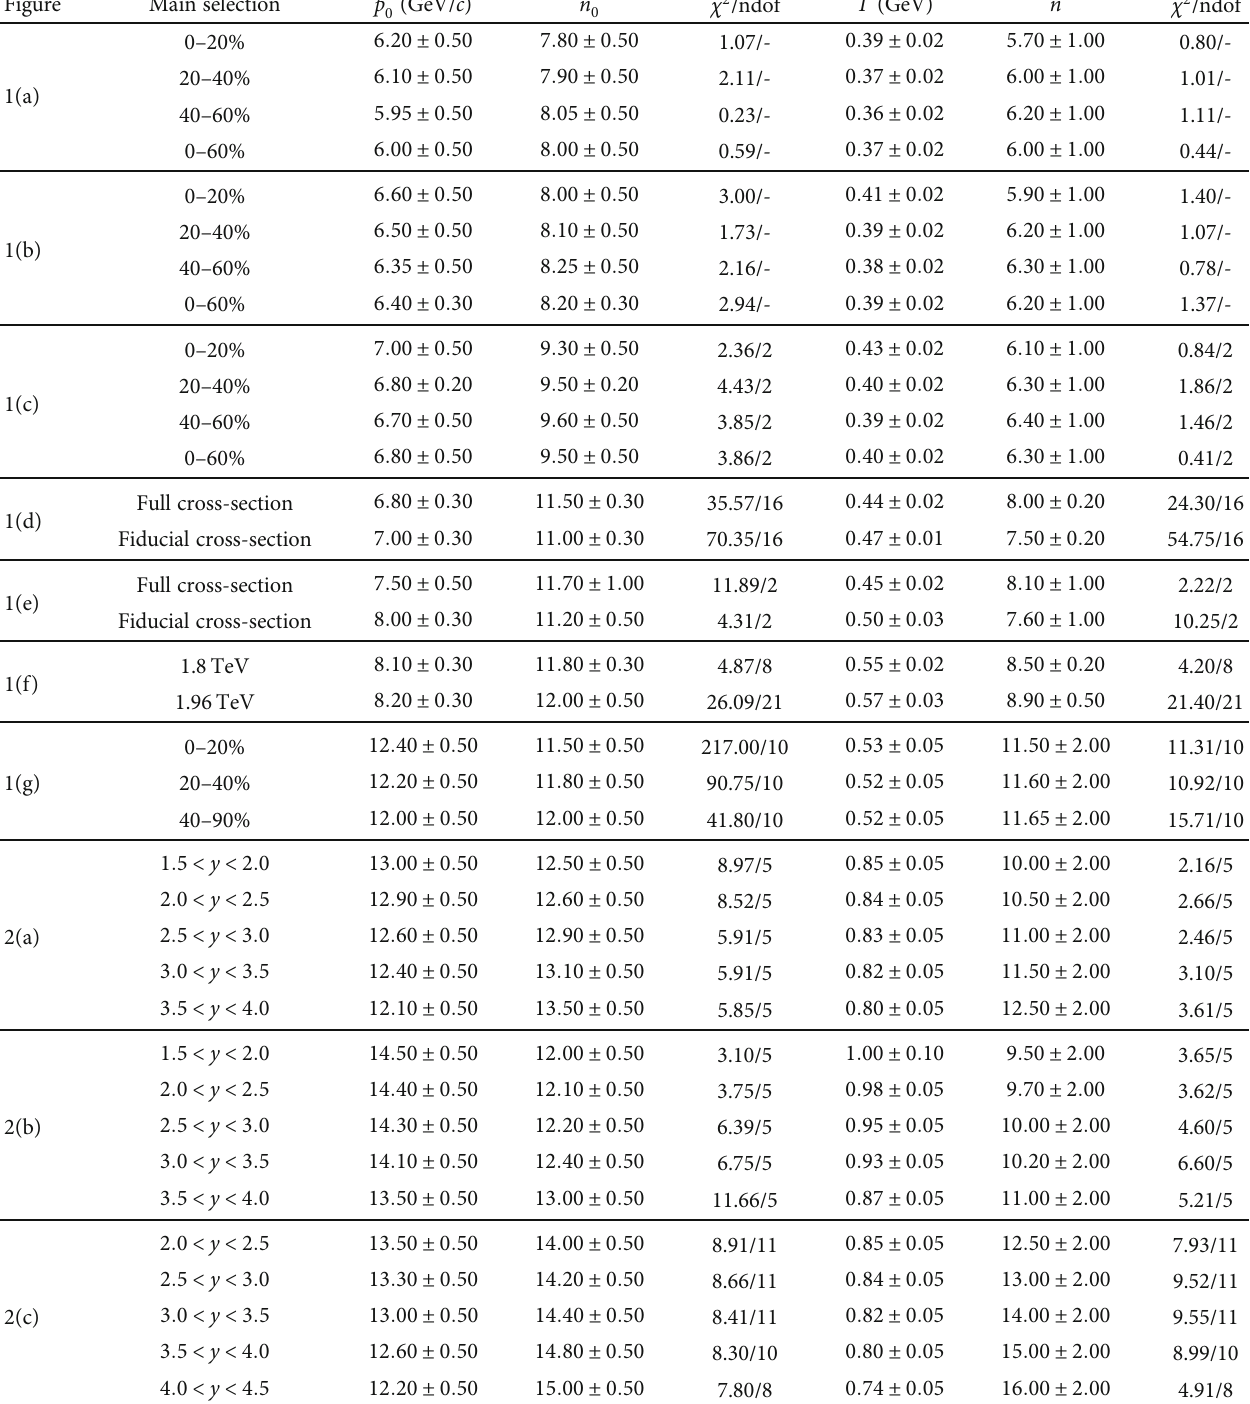
(a) Values of p 0 , n 0 , and χ 2 /ndof corresponding to the dashed curves in Figures 1 and 2, as well as values of T , n , and χ 2 /ndof corresponding to the dotted curves in Figures 1 and